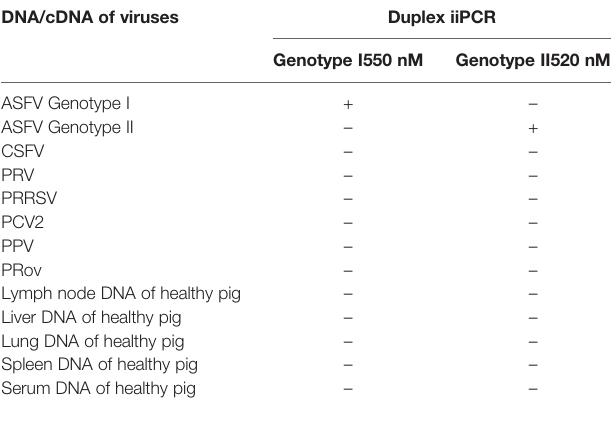
TABLE 3 | Speci fi city of the duplex iiPCR.